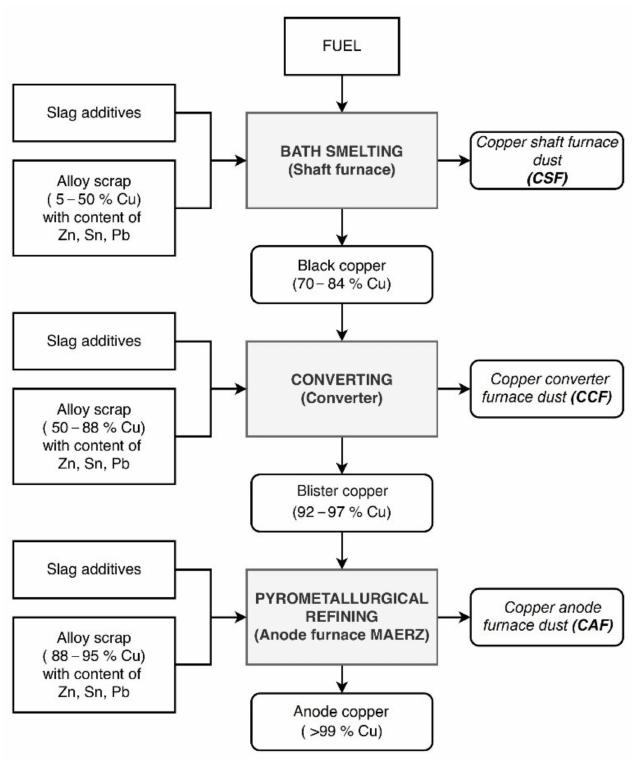
Figure 1. Copper furnace dust sample and particle size distribution